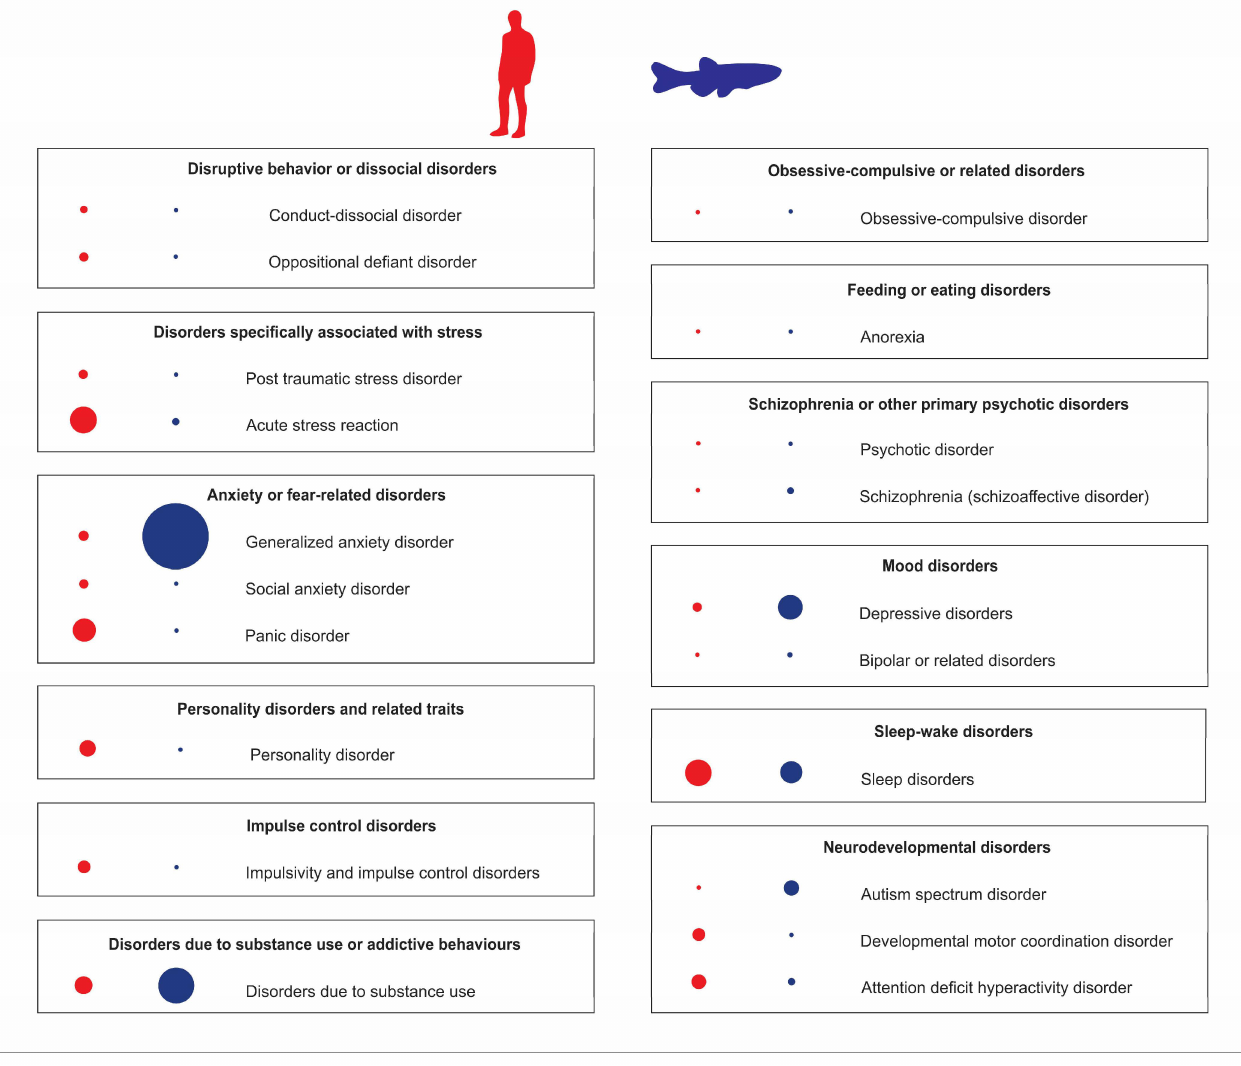
Figure 1. Analyses of Pubmed publications using zebrafish as an animal model of various human psychiatric disorders, compared to their clinical prevalence in adults. Blue dots (on the right) represent the relative number of zebrafish publications on specific psychiatric disorders, red dots (on the left) denote their relative clinical prevalence. The dot size reflects the relative frequency of each